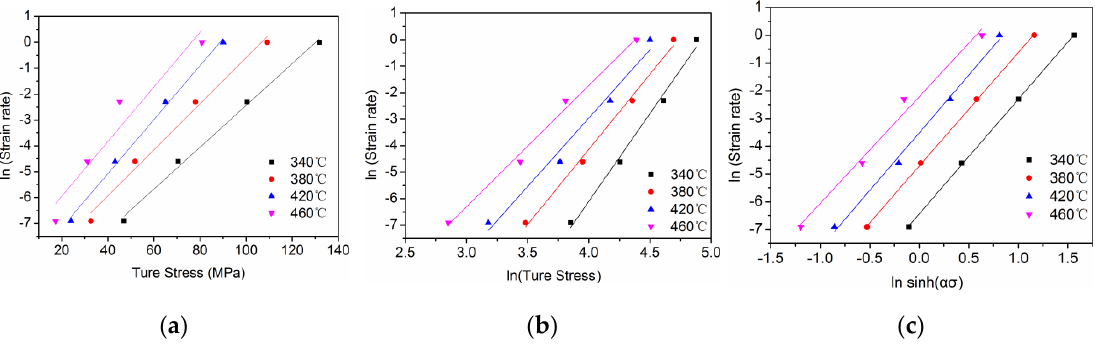
Figure 8. ( a ) lnε -σ; ( b ) lnε -lnσ; ( c ) lnε -ln[sinh(ασ)].